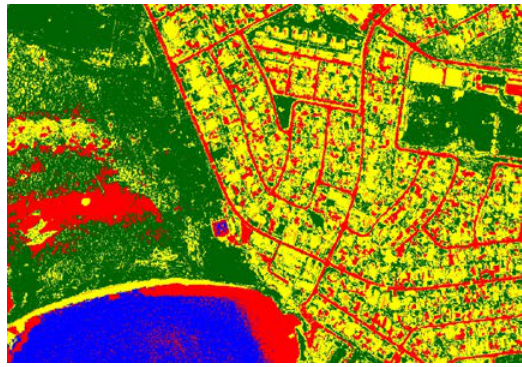
Figure 2: Results of supervised classification – maximum likelihood